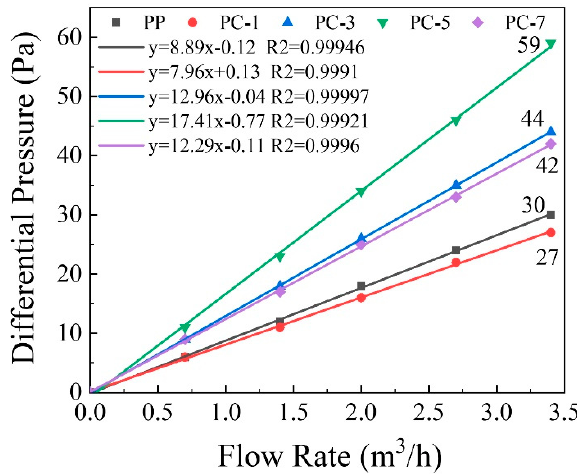
Figure 13. Pressure drop of the PP/PC membranes at five different flow rates (0.7, 1.4, 2, 2.7, and 3.4 m 3 /h).